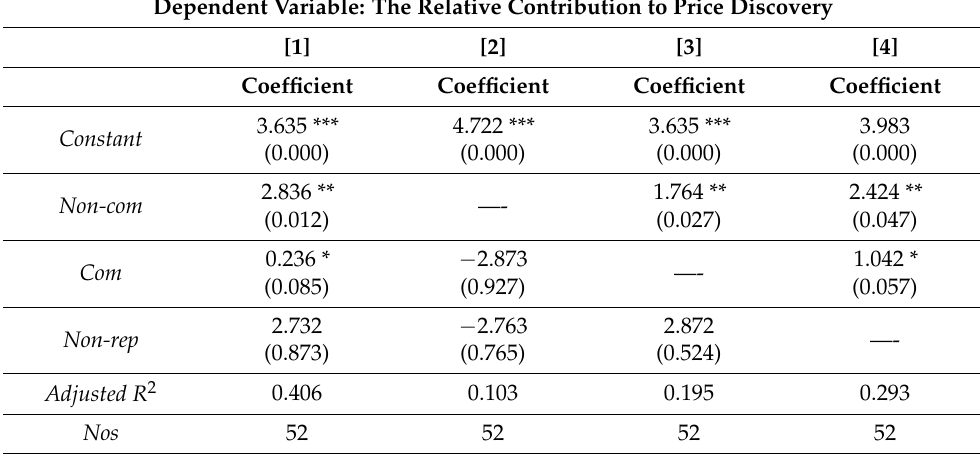
Table 6. Robustness check: effects of traders’ positions on information share. Dependent Variable: The Relative Contribution to Price